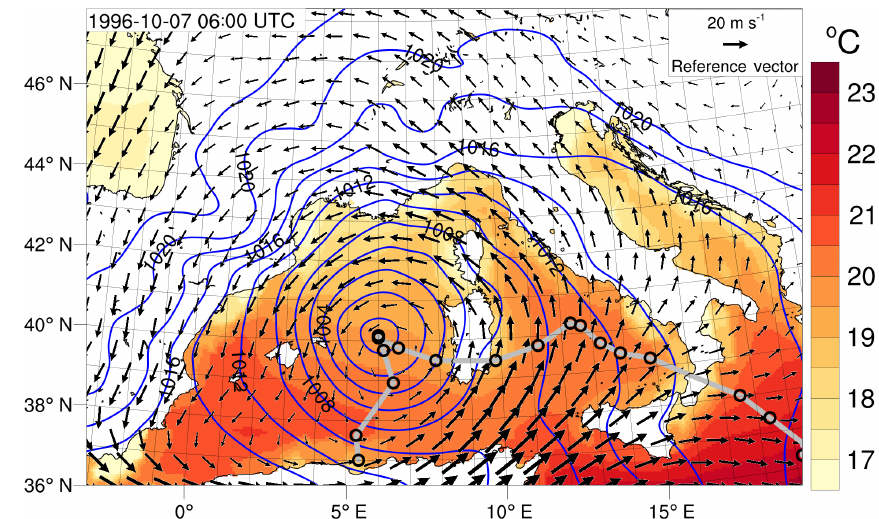
Figure 1. Inner simulation domain (0.0625 ◦ resolution) and medicane in reanalysis. SSTs (shading), sea level pressure (hPa, blue contours) and 500hPa wind vectors, representative of the steering flow, are shown for 7 October 1996 at 06:00UTC. The cyclone’s track is shown with a grey line, marked at 6h intervals from 6 October 1996 at 06:00UTC. The plot is based on ERA-Interim data.